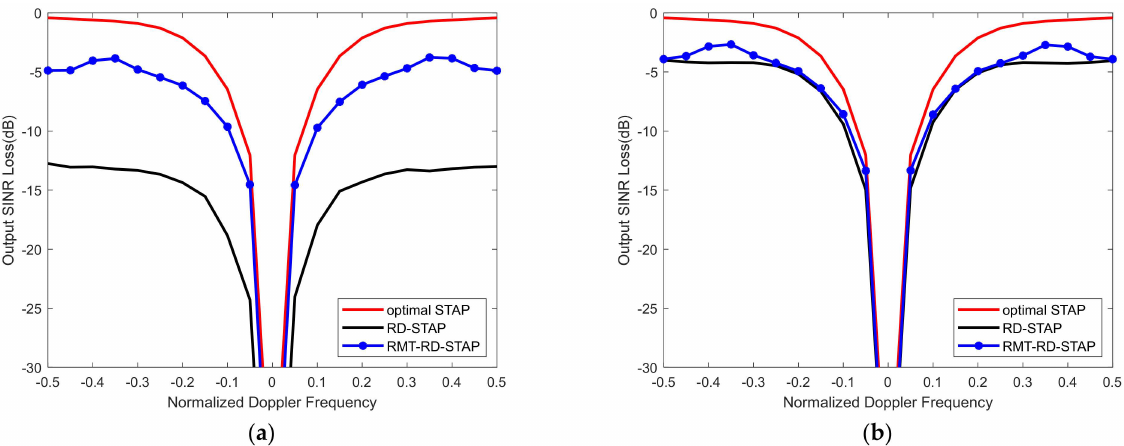
Figure 4. Output SINR losses versus normalized Doppler frequencies with V = 150 m/s. ( a ) L = M training samples and ( b ) L = 2 M training samples.